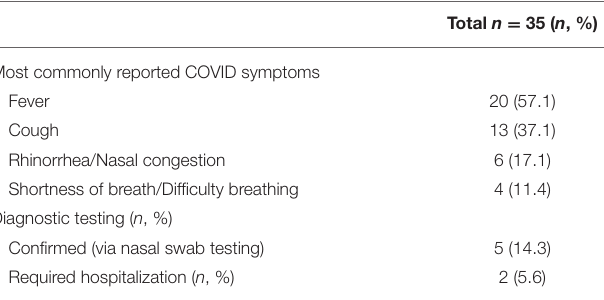
TABLE 2 | COVID status of children with medical